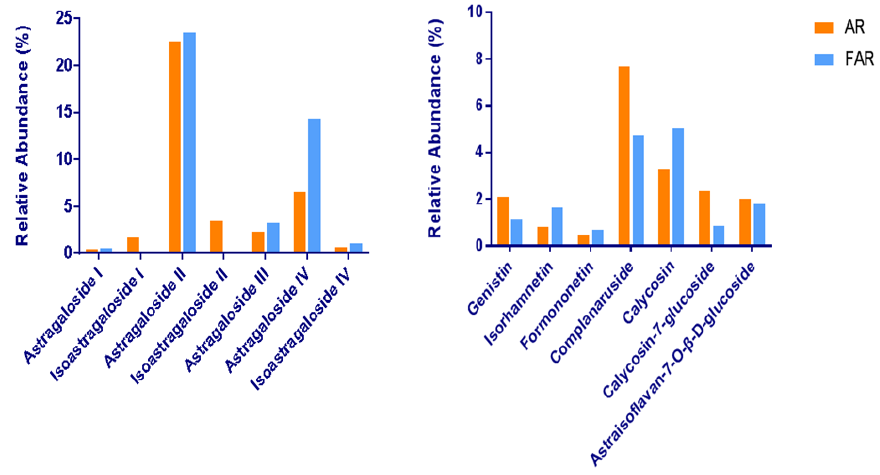
Figure 6. The changes in representative constituent contents in AR and FAR.